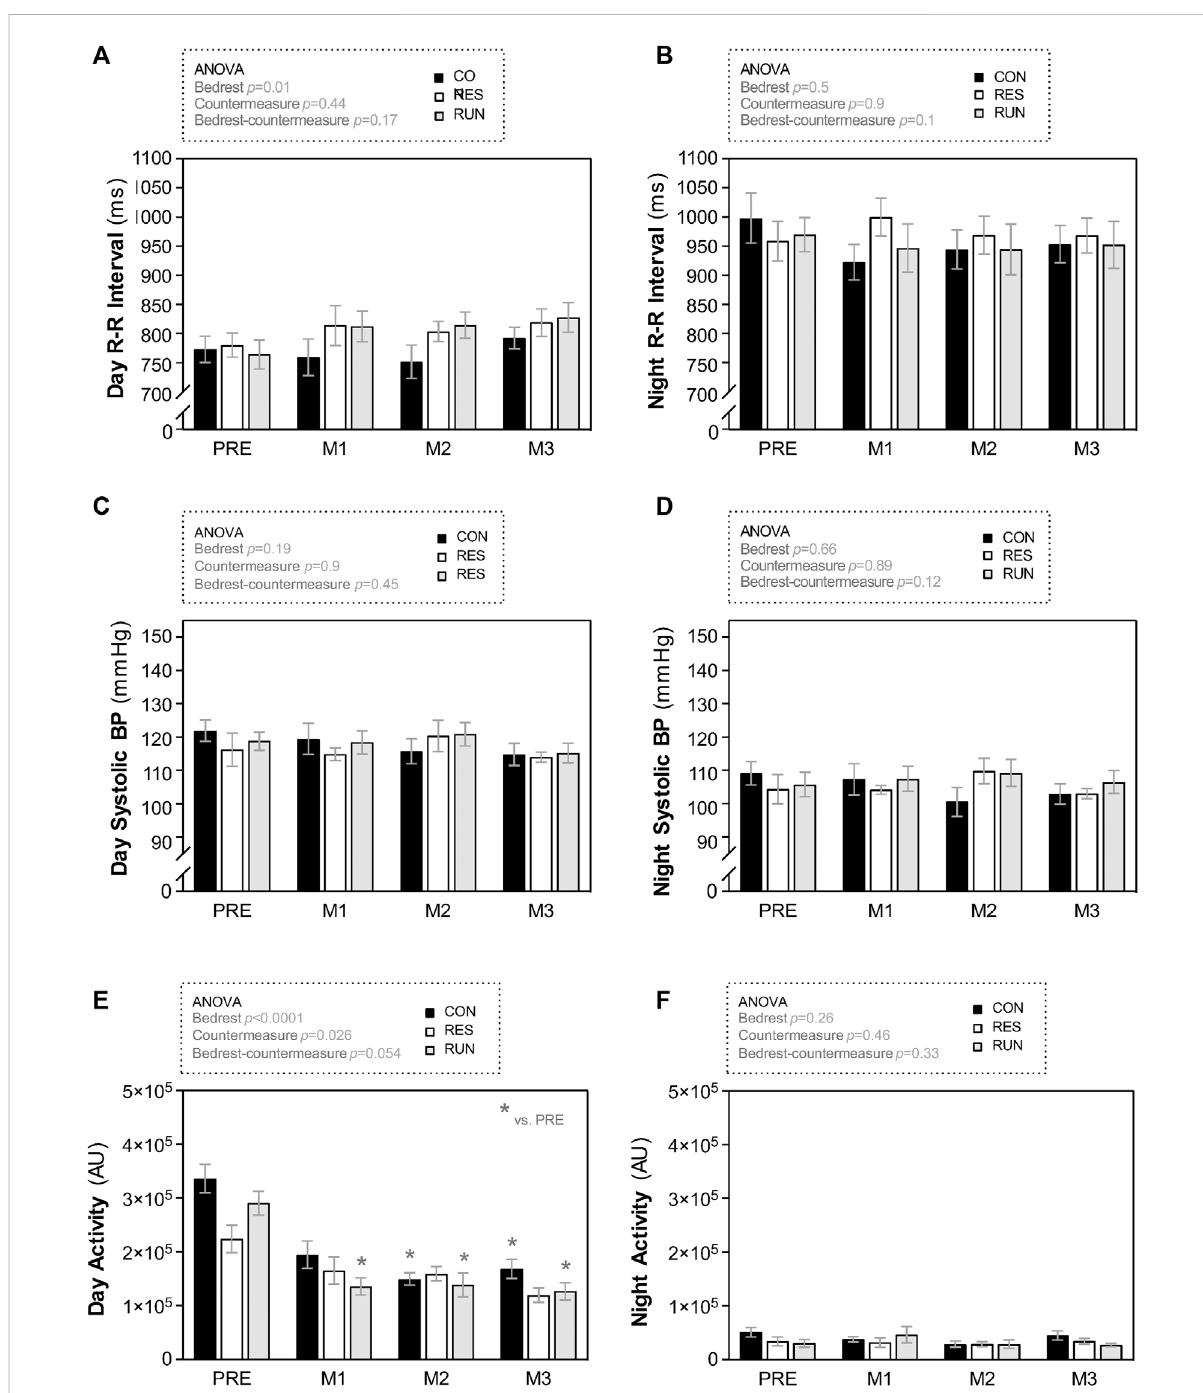
FIGURE 7 Evolution in fl uid compartments, body mass, and body composition during HDBR. Fluid compartments (A,C,D) body mass used for bioimpedance measurements (B) , and body composition (E,F) were estimated by bioimpedance measurements using a multifrequency impedance device.The subjectswereweighedprior to measurement,and bodymass dataused forcalculations. Thesamplesize was n =8/CON, n =7/RES, n = 7/RUN. Data are presented as the mean ± SEM. * p < 0.05 vs. Pre; # p < 0.05 vs.